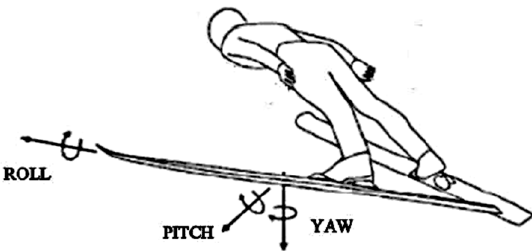
Figure 3. Representation of the roll, pitch, and yaw ski angles (adapted from [7]). The rotation arrows indicate how the positive directions of the ski angular movements were defined.